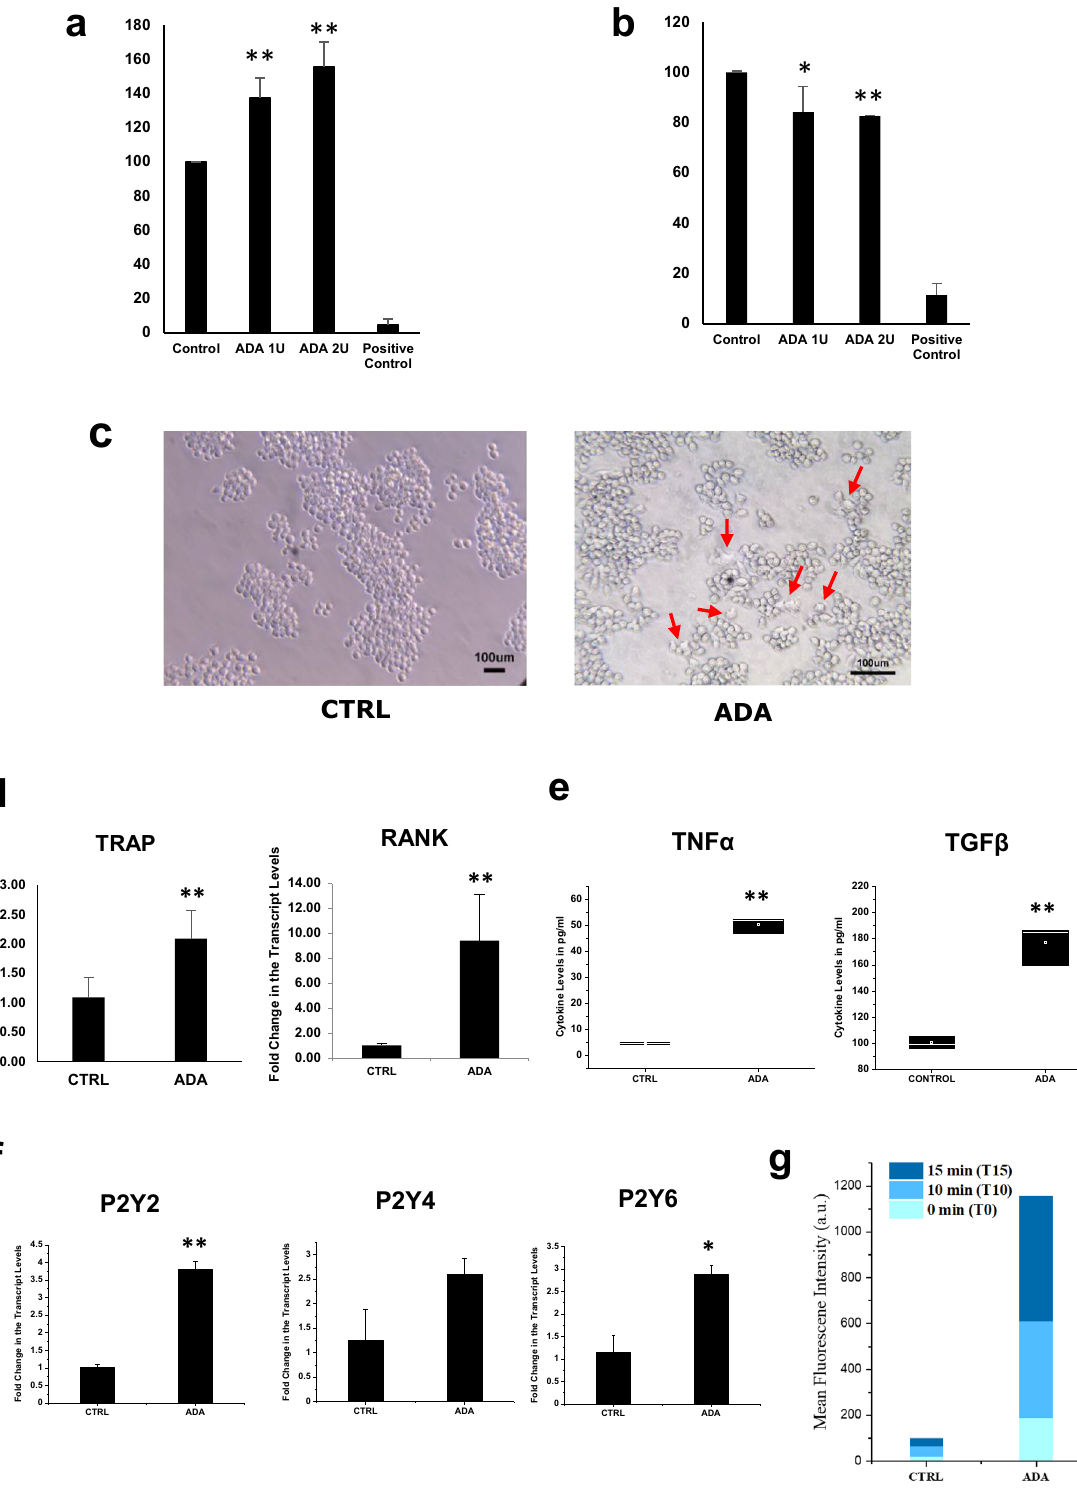
Figure 5. ADA is involved in joint remodeling in rheumatoid arthritis—in vitro studies to investigate the role of ADA in joint remodeling in the affected joint. ( a ) Increased proliferation of Synoviocytes, ( b ) Decreased cell viability in primary chondrocytes. ( c ) Increased Osteoclast differentiation of macrophages and ( d ) qPCR analysis showing the expression of osteoclast markers after 72 h exposure to ADA. ( e ) Increased cytokine levels in the spent medium after 72 exposure to ADA. ( f ) P2Y 2 , P2Y 4 , and P2Y 6 receptor expression in macrophages after 72 h of ADA exposure. (showing *representing a p value of ≤ 0.05, and **representing a p value of ≤ 0.005). ( g ) Increased ROS in macrophages after ADA exposure (p values of ADA to CTRL on all time points are ≤ 0.005). All the plots were made using Origin